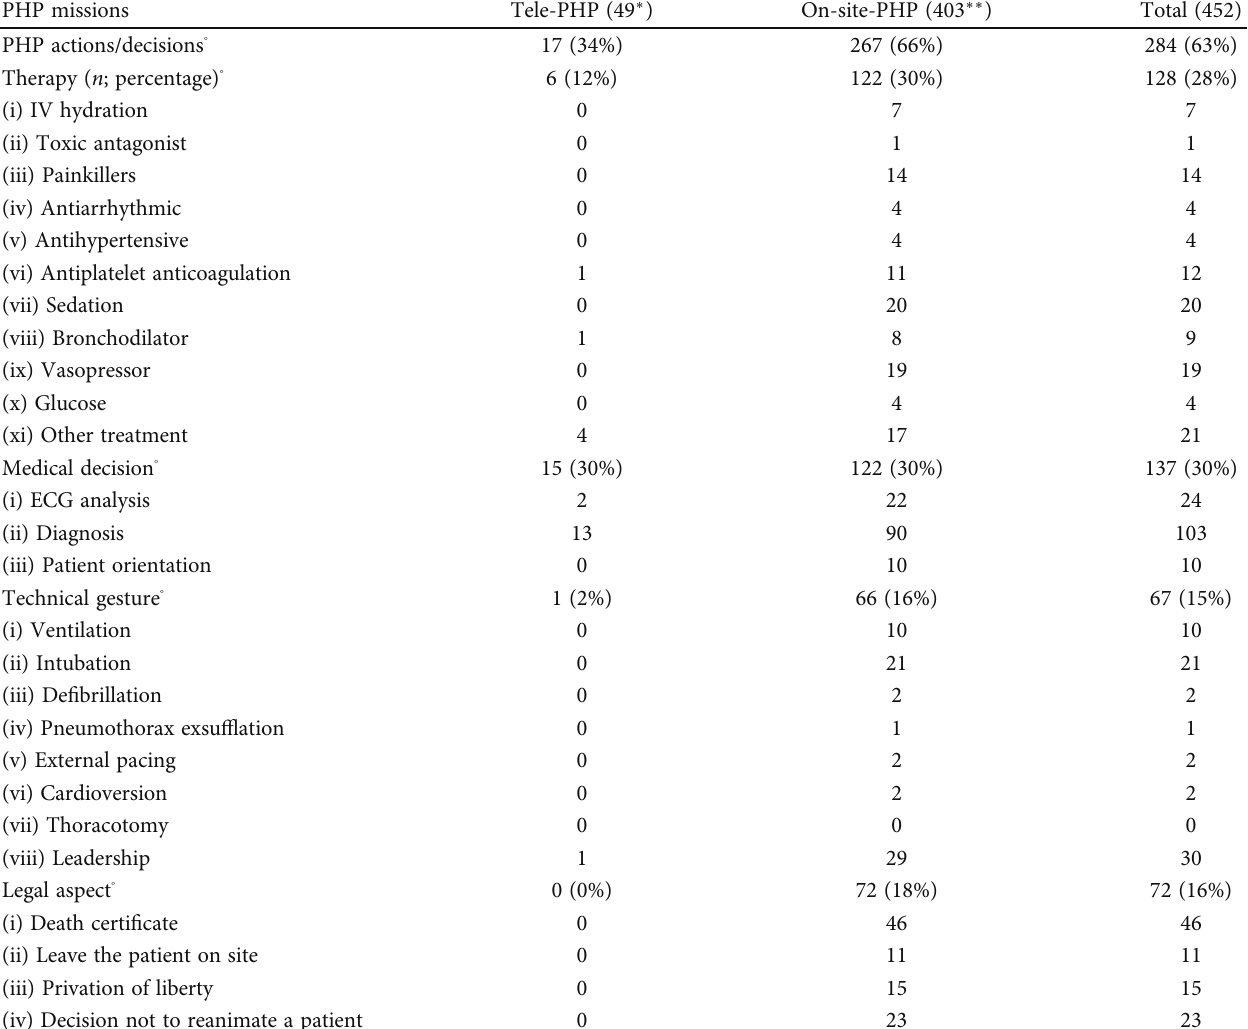
Table 5: Details of prehospital emergency physician (PHP)